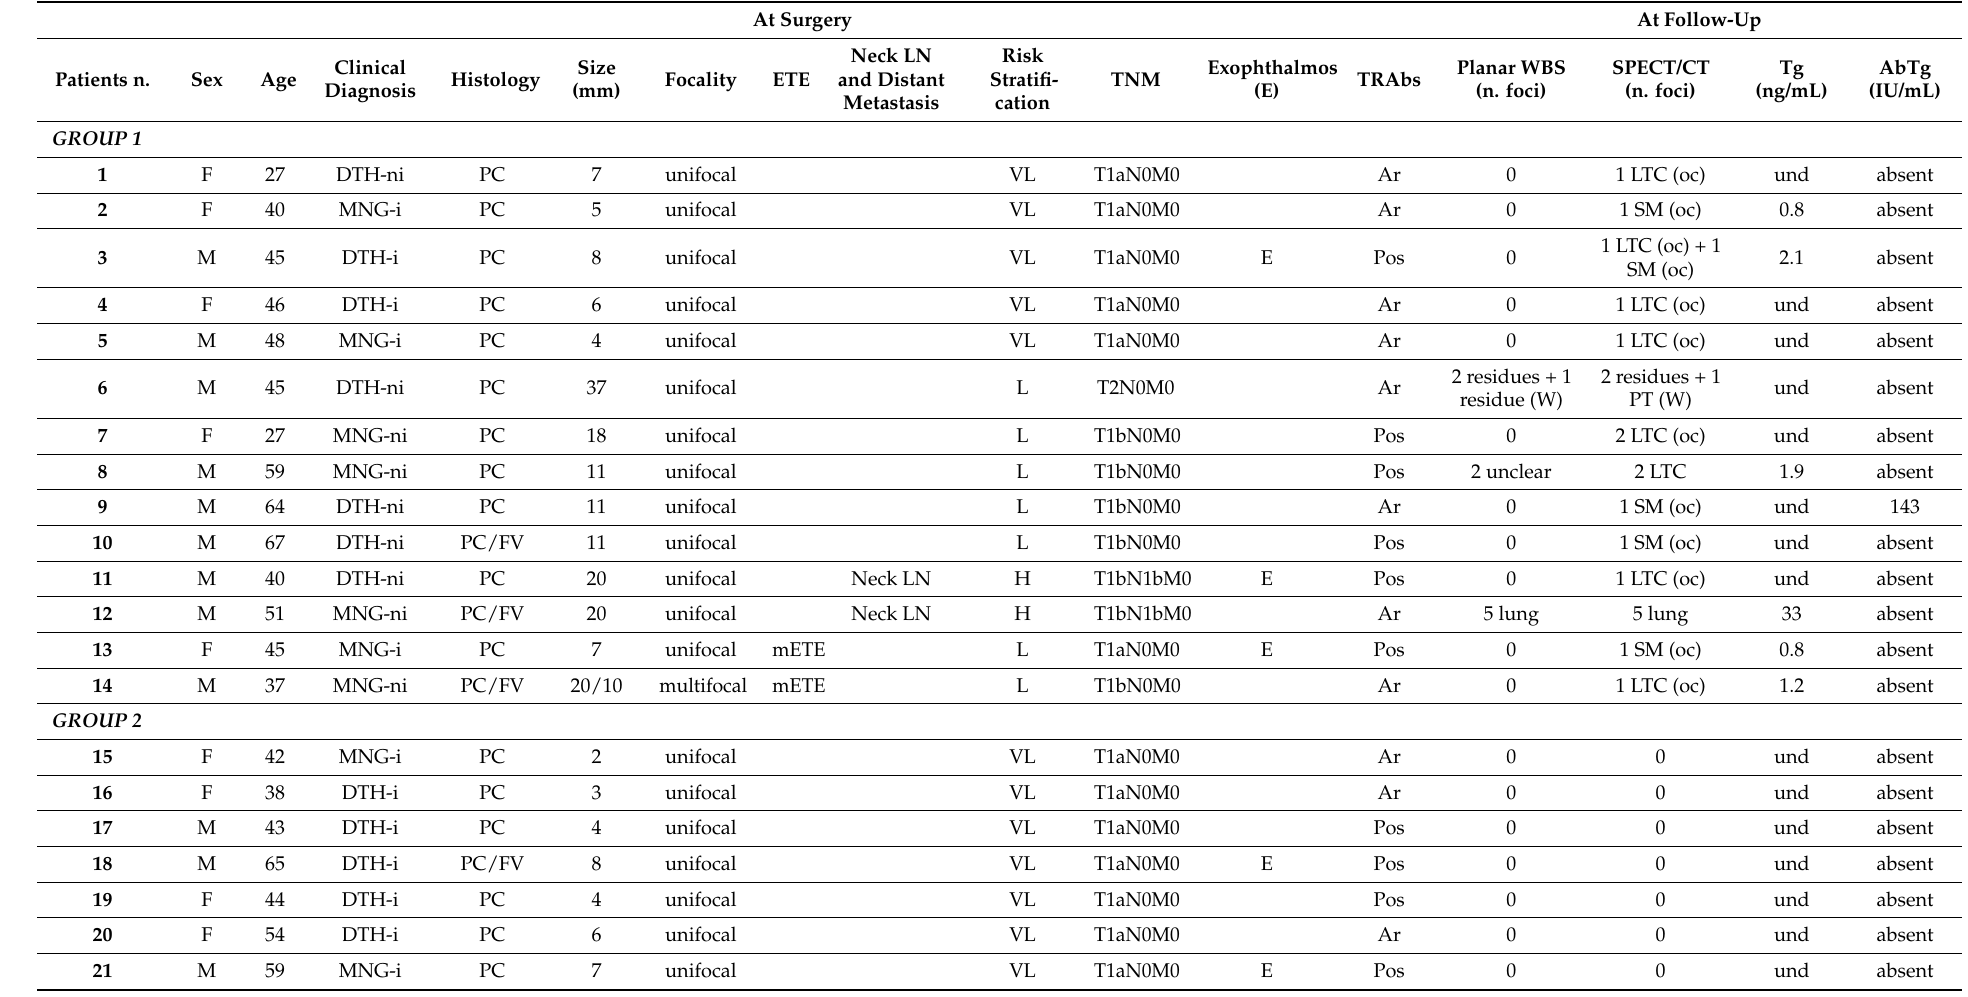
Table 2. Clinical-pathological data of 33 patients with PC and associated GD at the surgery of primary tumor and at long-term follow-up. The carcinomas of Patients 1–14 (Group 1) had aggressive behavior, while Cases 15–33 (Group 2) did not develop